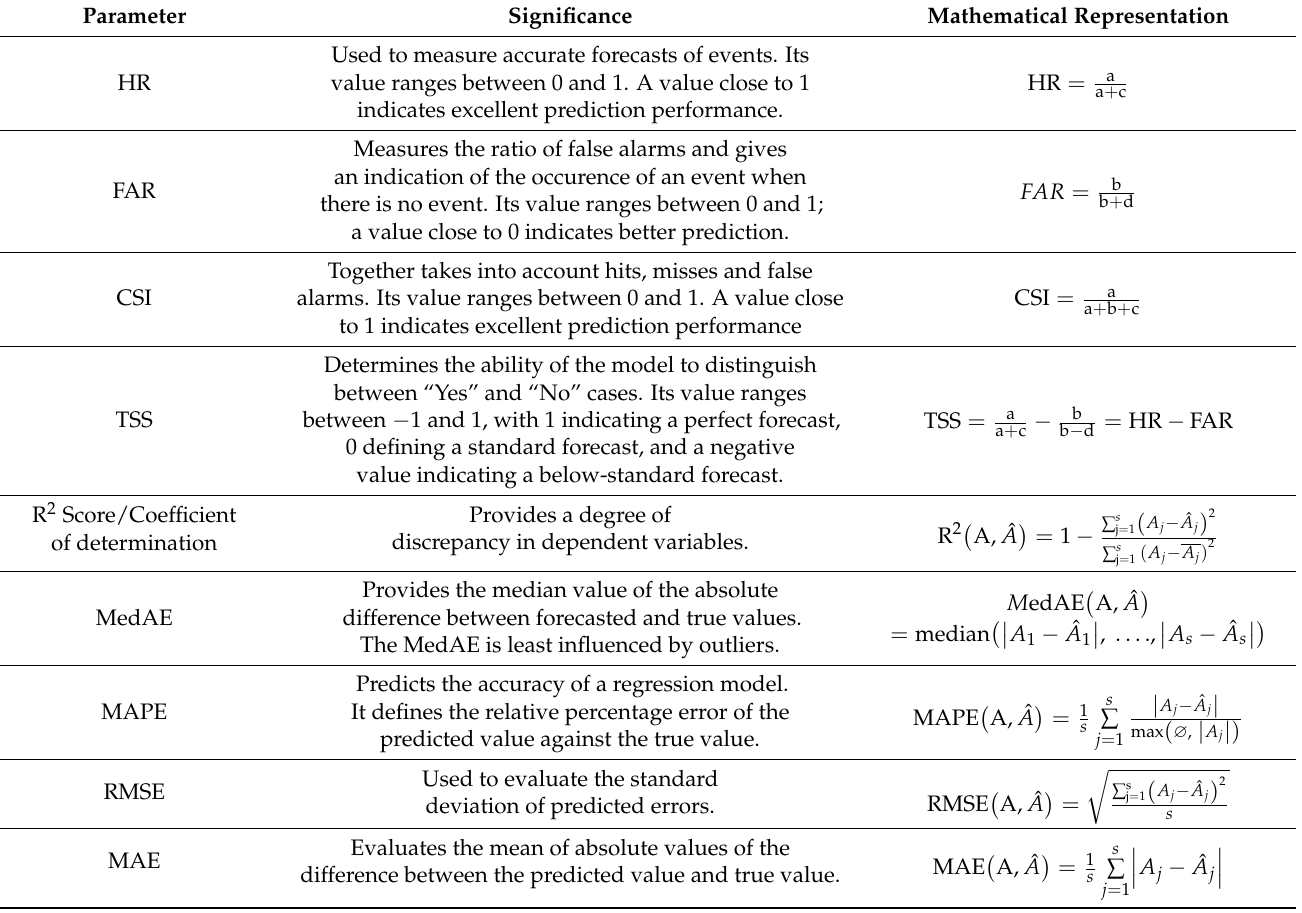
Table 4. Performance measurement indicators for regression prediction model validation and verifi- cation of high concentration.